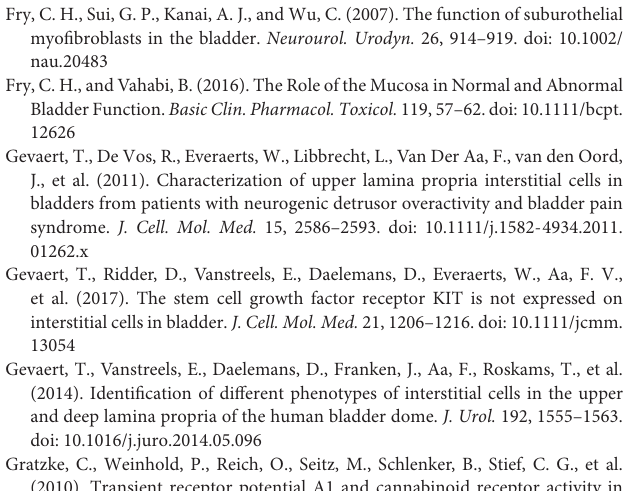
Supplementary Figure 1 | Immunofluorescence for TRP/ Piezo channels were significantly reduced after knocking down their mRNA expressions (A–G) . The control images were from the sections treated with nontargeting siRNA. Supplementary Figure 2 | Cultured LP-ICs exhibit spontaneous Ca 2 + activity and are responsive to ATP. (A) Typical traces showing 75% of ICs having spontaneous Ca 2 + activity. (B) Typical traces showing ATP (100 µ M) evoked a significant increase in [Ca 2 + ]i in LP-ICs. Supplementary Figure 3 | Only a TRPV4 agonist evokes an increase in [Ca 2 + ]i in cultured human urothelial cells. The duration and concentration for each agonist applied are identical to those applied for LP-ICs shown in Figure 4 . The scale bar is applied to all figures. Supplementary Table 1 | The sequences of siRNAs for RNA